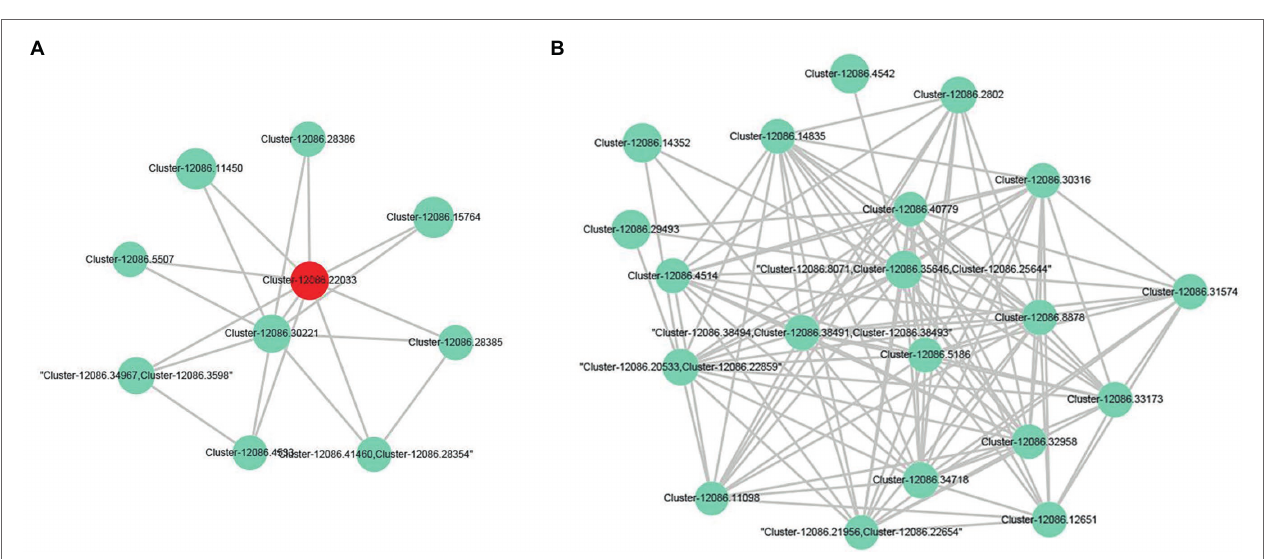
FIGURE 6 | Sub-network containing the two fruit color-associated markers. (A) represents the gene in which the association marker OREST22 is located and the DEGs in which it is interassociated. (B) represents the DEGs of the gene containing the potential association marker OREST1 and its protein interaction.